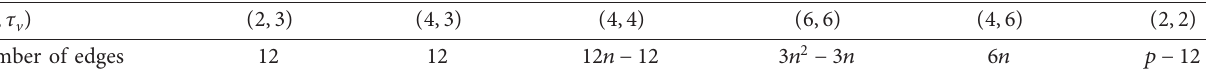
Table 4: Edge partition of HGSCNC ( n,m ) ∀ n ≥ 2 and p ≥ 14.